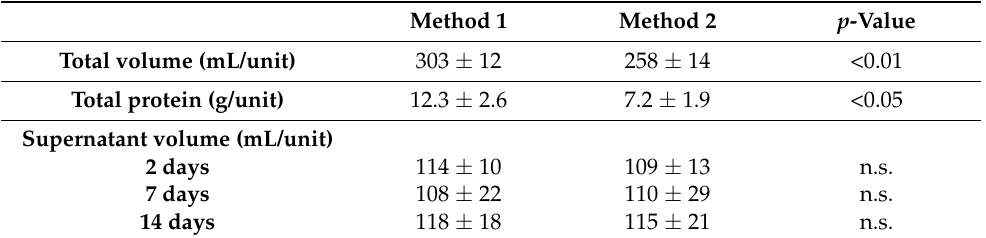
Table 1. Total volumes, total protein content and supernatant volumes of the P-RBCs prepared with the two methods. Method 1 Method 2 p -Value Total volume (mL/unit) 303 ± 12 258 ± 14 <0.01 Total protein (g/unit) 12.3 ± 2.6 7.2 ± 1.9